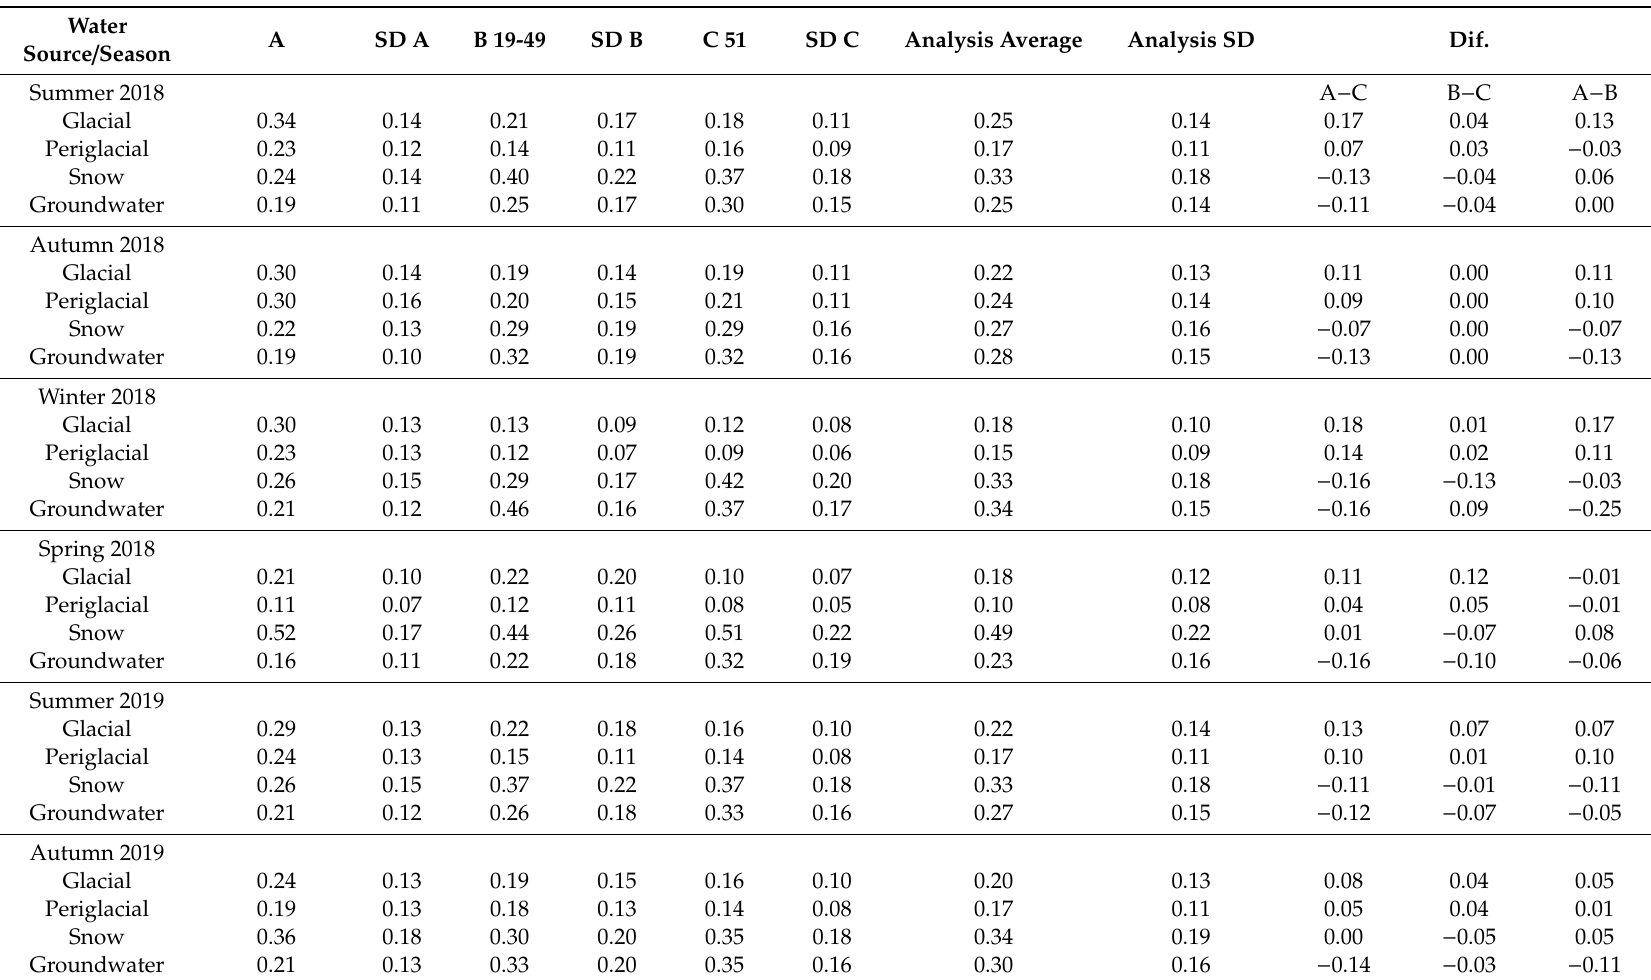
Table 4. Proportional contribution of each water source to the headwaters of the Aconcagua River basin according to di ff erent “simmr” analysis.